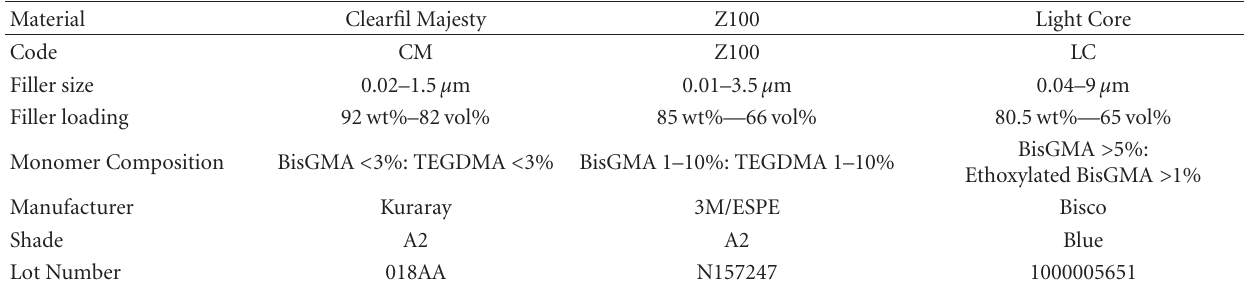
Table 1: Composite brands tested in the study and their monomer composition according to manufacturers’ data.